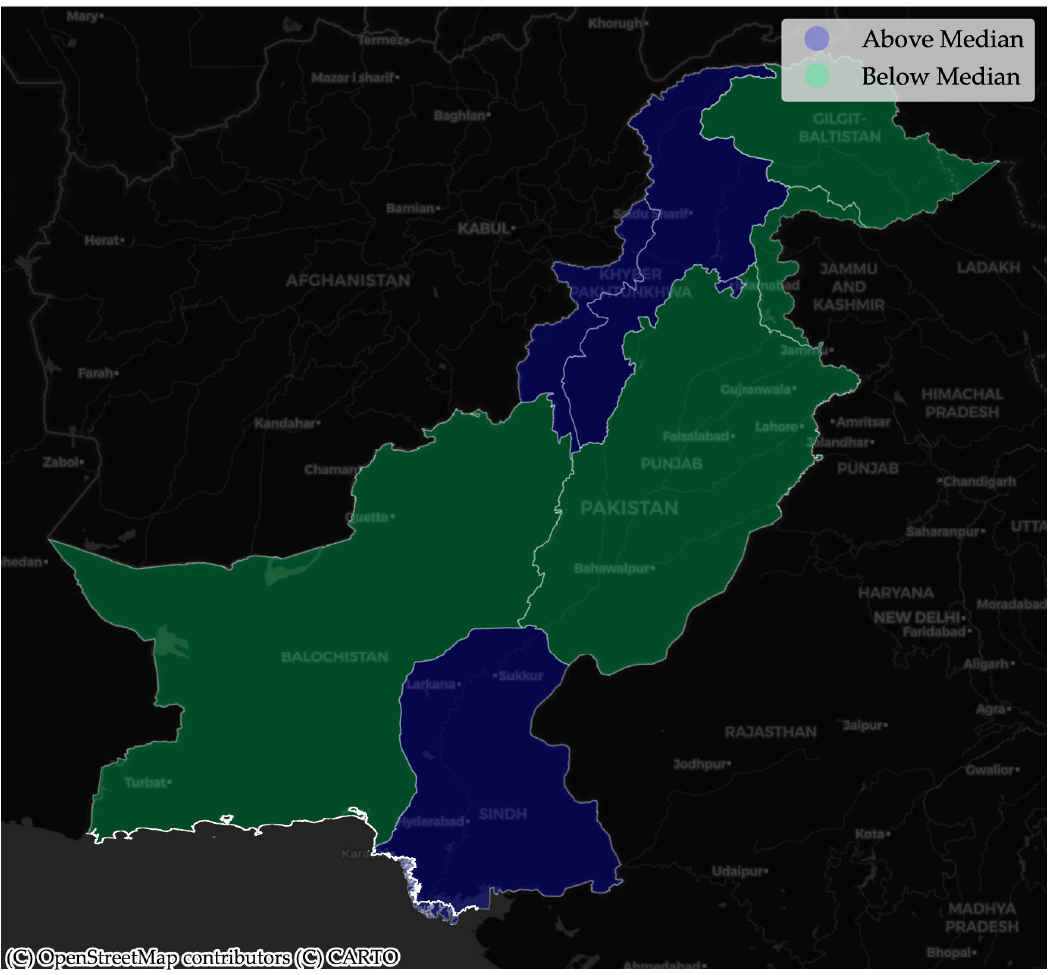
Figure 11. Segregation of Pakistan’s administrative boundaries using the GTI-IS density statistic. Table 7. Joint count statistics for spatial autocorrelation in